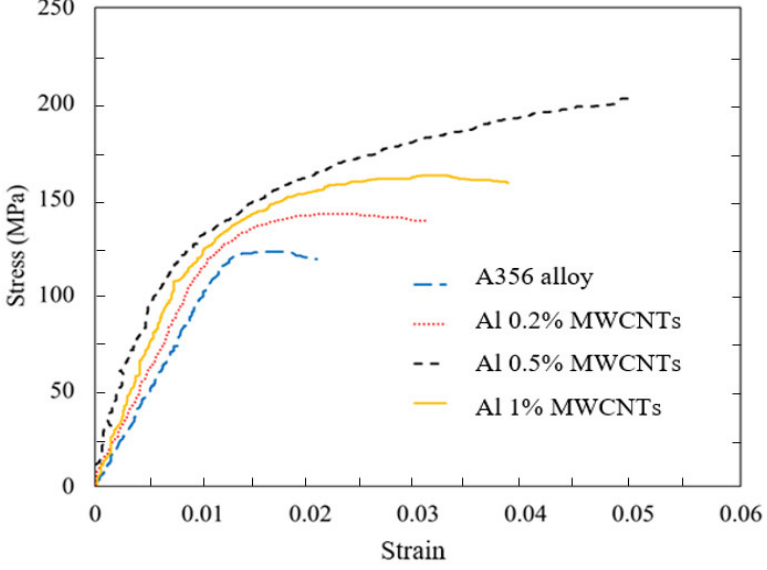
Figure 6. The stress–strain diagram of A356 aluminum alloy and nanocomposites containing 0.2%, 0.5%, and 1% MWCNT addition.